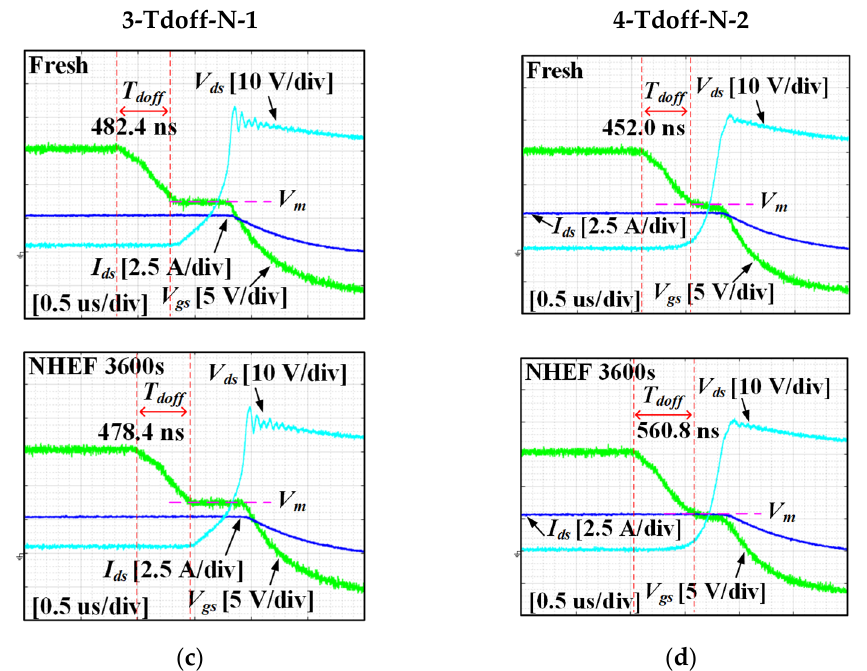
Figure 18. Turn off waveforms in NHEF stress: ( a ) 1-Tdoff-P-1, ( b ) 2-Tdoff-P-2, ( c ) 3-Tdoff-P-1, and ( d ) 4-Tdoff-P-4.